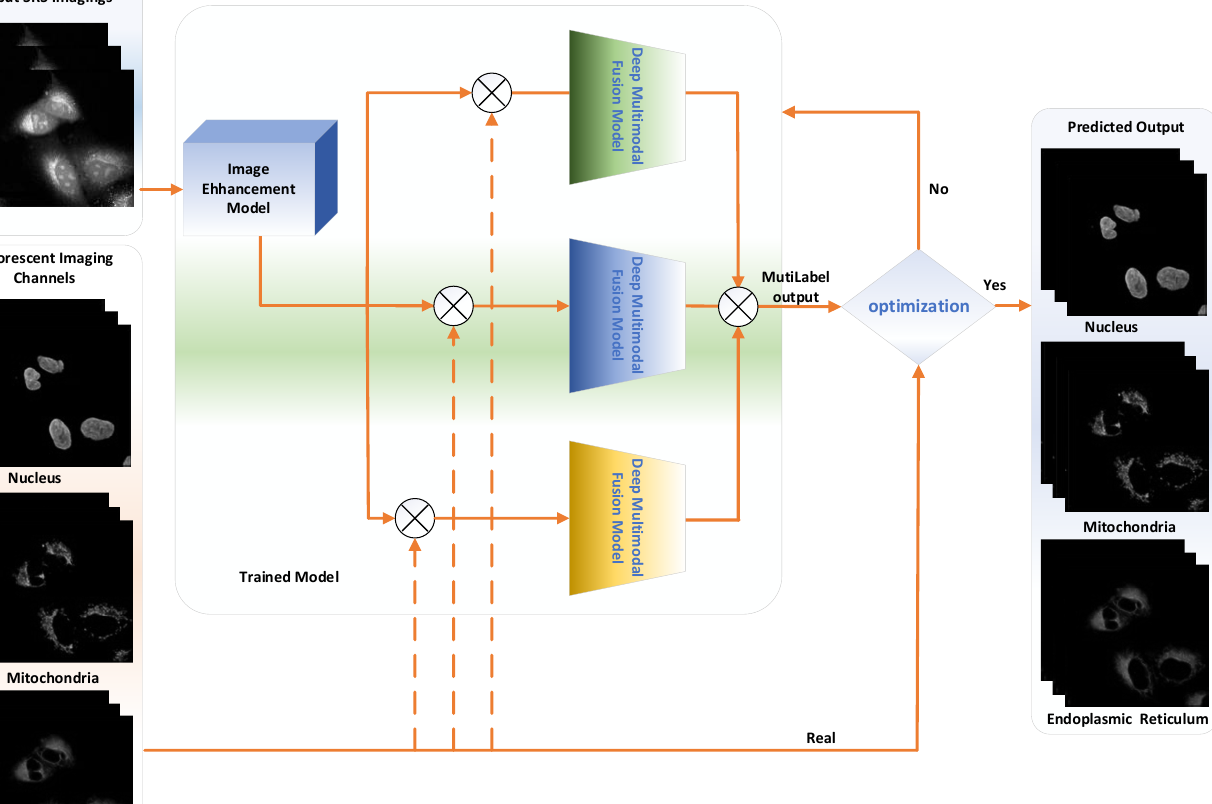
Figure 12. Graphical overview of our proposed deep MPF architecture. It includes five Modules: Input SRS imagings, Fluorescent Imaging Channels, Trained Model, Optimization and Predicted Output.